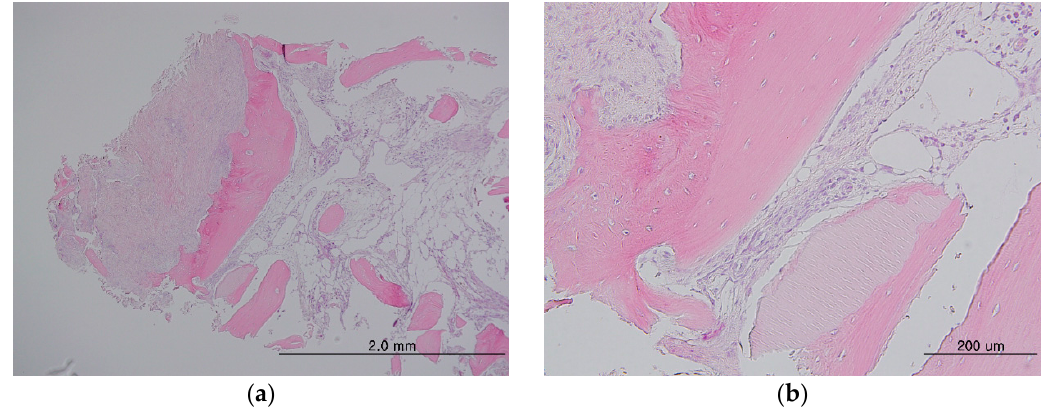
Figure 8. Histology specimens from the maxilla and sinus ( a ) showing dense fibrous connective tissue on the left of the newly-formed bone, whereas tissue rich in angiogenesis can be seen on the other side of the new bone. Higher magnification showing newly-formed bone with embedded osteocytes surrounding the particles and direct contacts between the bone and particle with the vasculature ( b ). No inflammatory cellular infiltration can be observed.